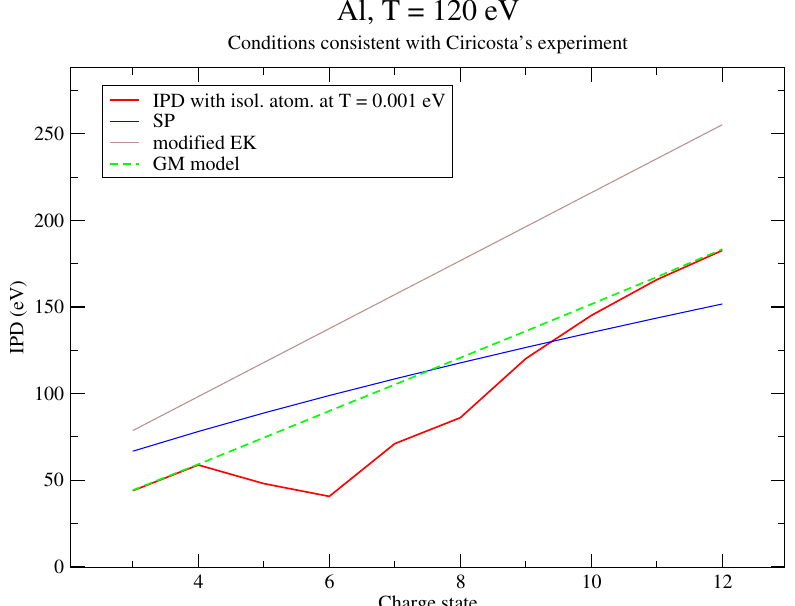
Figure 10. IPD of the different charge states for an aluminum plasma at T = 120 eV: our calculation (red curve), Stewart-Pyatt model (blue curve), modified Ecker-Kröll model (brown curve) and GM model (green dashed curve).